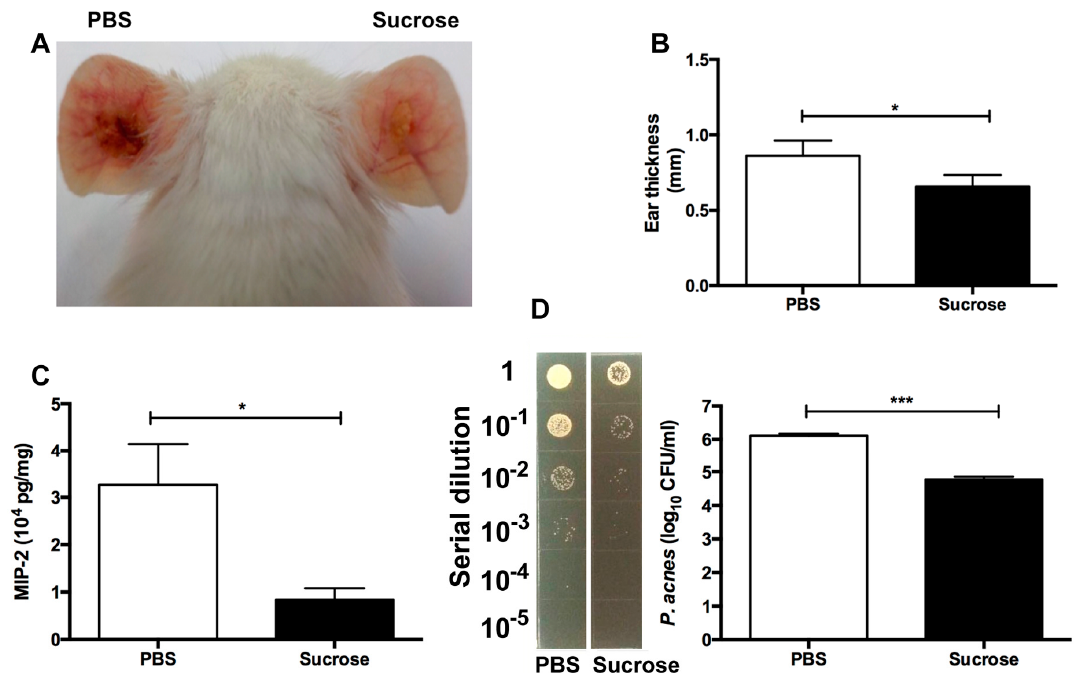
Figure 4. In Vivo reduction of P. acnes colonization and inflammation by S. epidermidis sucrose fermentation. The ears of Institute for Cancer Research (ICR) mice were injected intradermally with P. acnes (ATCC 6919) (10 7 CFU) and S. epidermidis (ATCC 12228) (10 7 CFU) with sucrose (20 g/L in 10 μ L PBS) or 10 μ L PBS. ( A ) A photo of ear inflammation was taken three days after injection; ( B ) The ear thickness (mm); ( C ) The levels of macrophage-inflammatory protein-2 (MIP-2) cytokines in the ears injected with bacteria in the presence of sucrose or PBS was measured by an enzyme-linked immunosorbent assay (ELISA) kit; ( D ) The CFUs in the ears injected with bacteria in the presence of sucrose or PBS were enumerated by plating serial dilutions (1:10–1:10 5 ) of the homogenate on an agar plate. Three days after injection, p -values were evaluated using two-tailed t -tests. Data are the means of three separate experiments using four mice per group. *** p < 0.001; * p < 0.05.